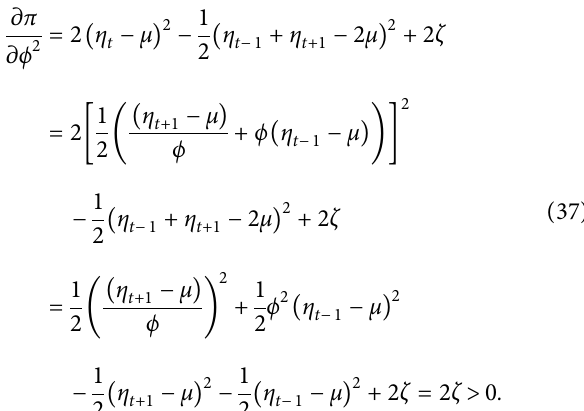
Figure 10: The change diagram of the loss curve oscillation during the model training process.